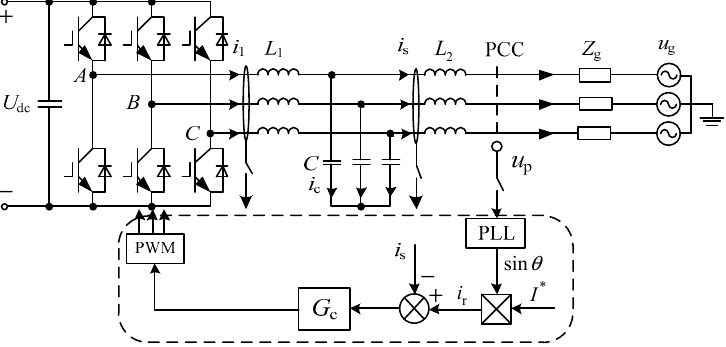
Figure 1. Control strategy of the grid-connected inverter for grid-side current feedback control structures.